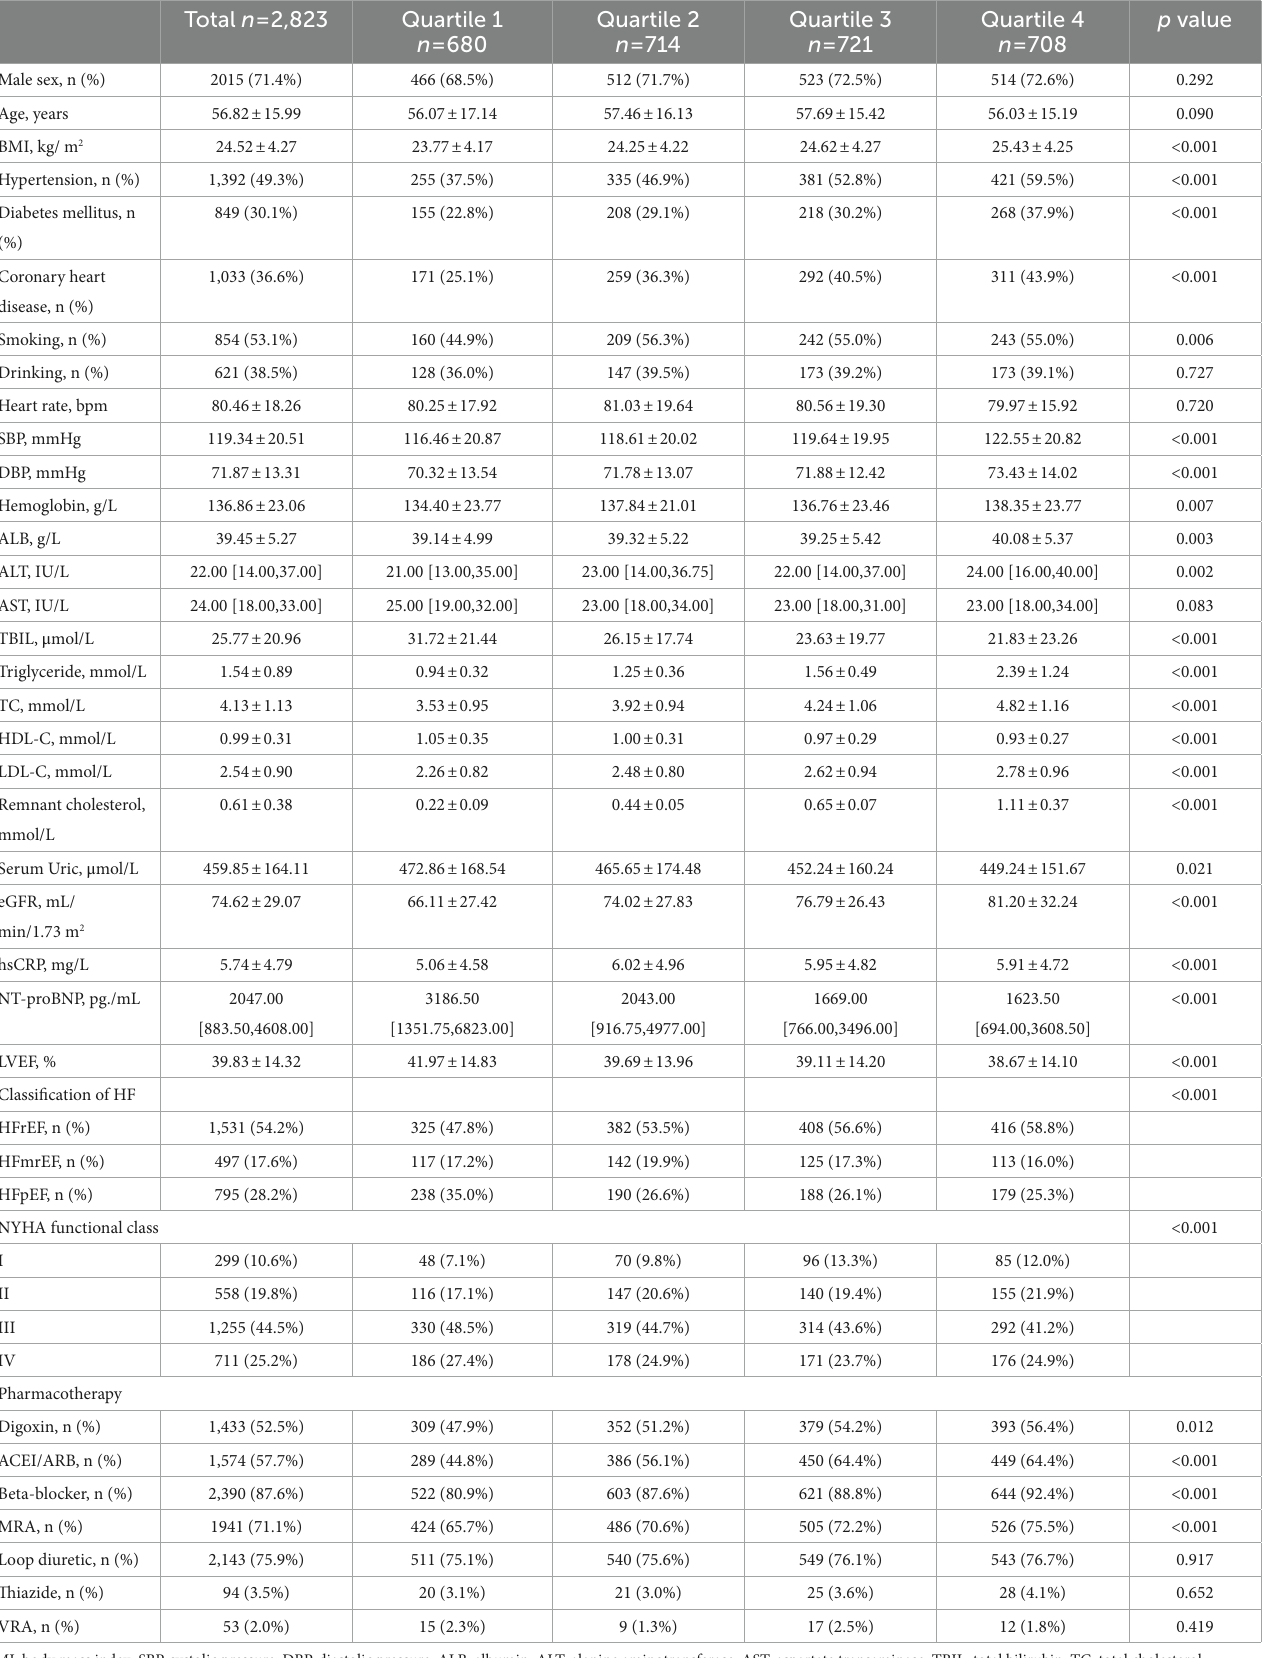
TABLE 1 Baseline characteristics by quartiles of remnant